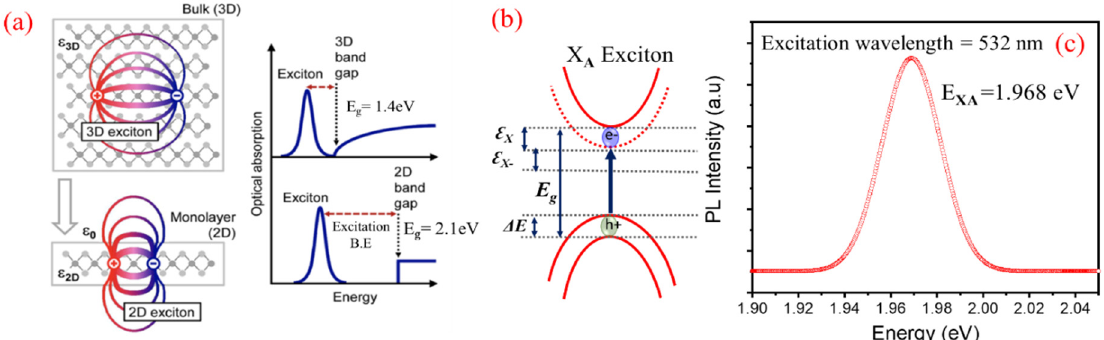
Figure 6. ( a ) Schematic diagram showing the reduced dielectric screening on the e-h pair bonding in a typical 2D material [38–40]. ( b ) Neutral A-excitonic transition ( X A ) in the energy level diagram, and ( c ) PL spectra of WS 2 grown over Si/SiO 2 substrate.